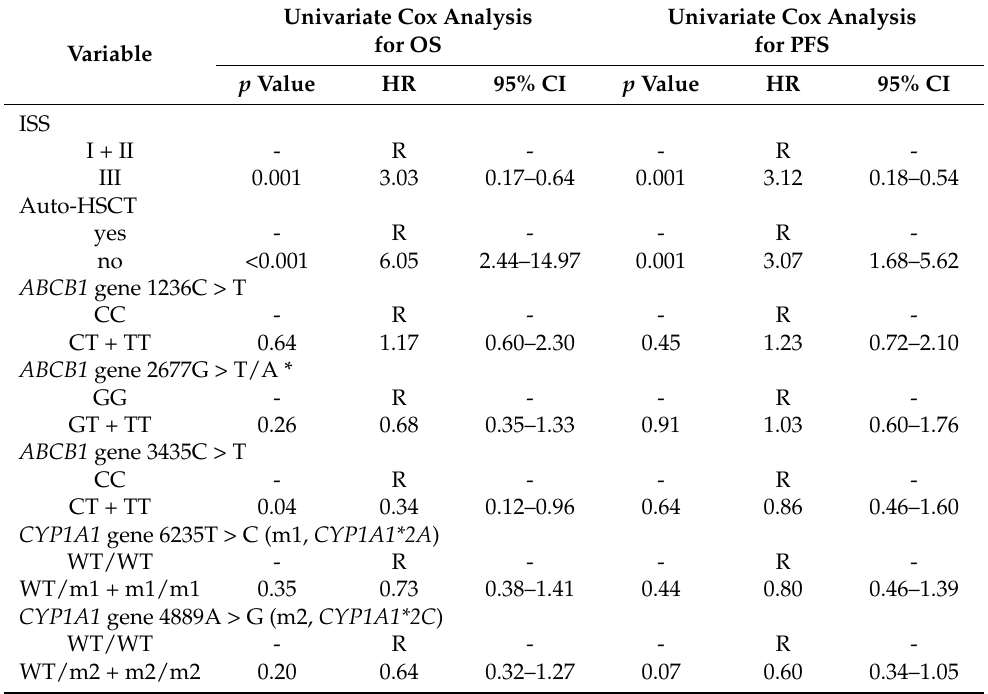
Table 4. Univariate Cox analysis in survival of MM patients.